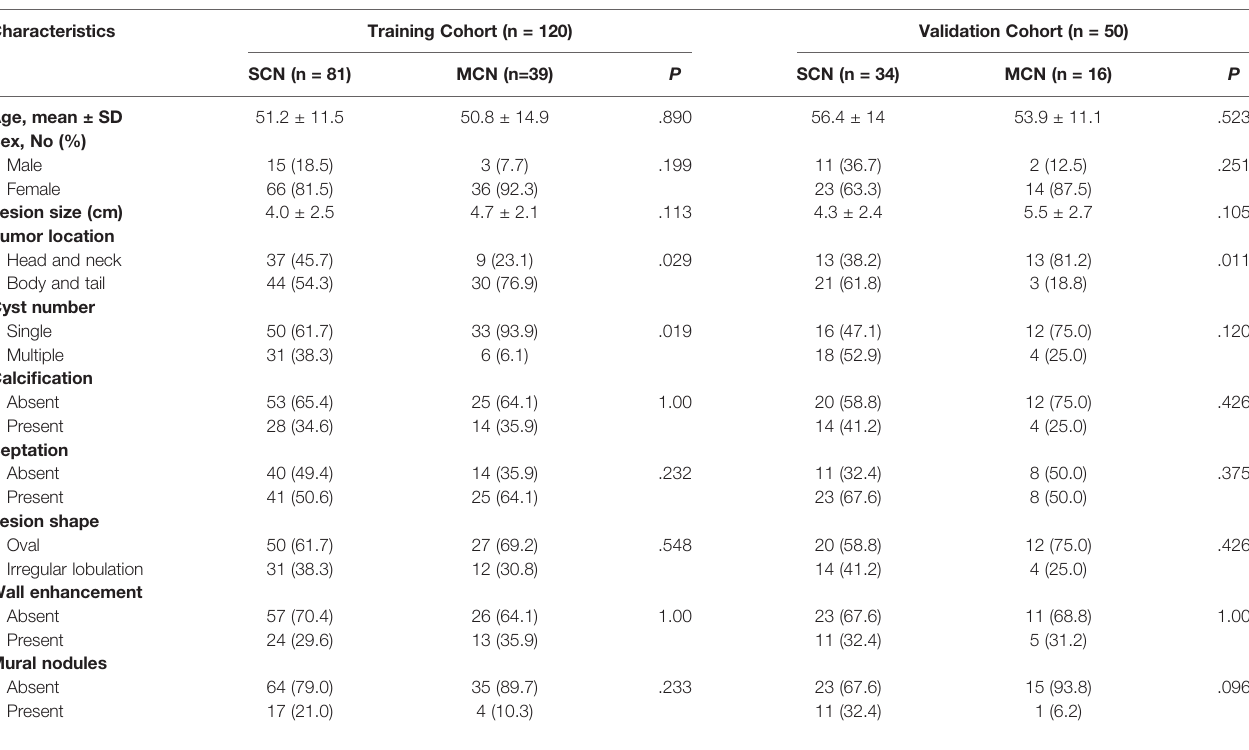
TABLE 1 | Characteristics of Patients in the Training and Validation